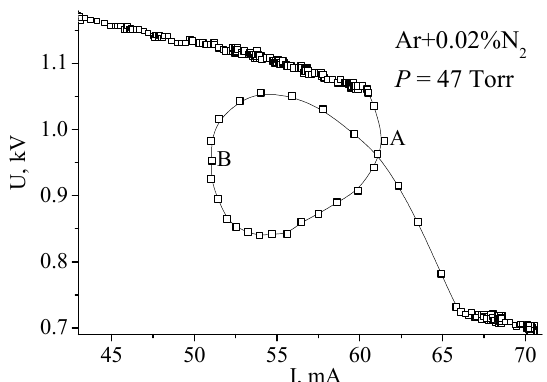
Figure 11. Volt–amp characteristic recorded at lowering (from point A) and increasing (from B) of power supply voltage [16]. (© IOP Publishing. Reproduced with permission. All rights reserved.)